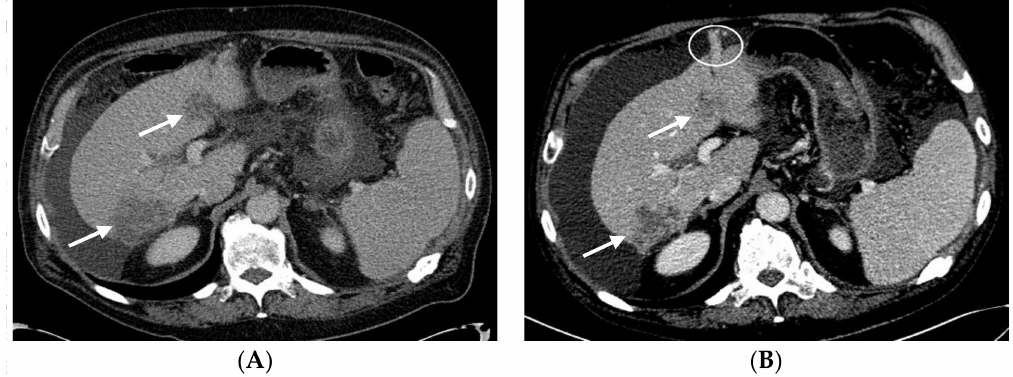
Figure 4. The tumors remained stable following cycle 9 and cycle 15 with CAPOX-B. ( A ) Following cycle 9 with CAPOX-B, the axial contrast-enhanced CT scans demonstrate stable heterogeneous hepatic tumors (arrows) compatible with a diagnosis of hepatocellular carcinoma. The right hepatic lobe tumor is subcapsular in location. There are small peri-hepatic and peri-gastric ascites. ( B ) Following cycle 15 with CAPOX-B, the axial contrast-enhanced CT scans demonstrate persistent heterogeneously enhanced hepatic tumors of a stable size (arrows). Progressive peri-hepatic and peri-gastric ascites with recanalized para-umbilical vein (circle) and splenomegaly can be seen.